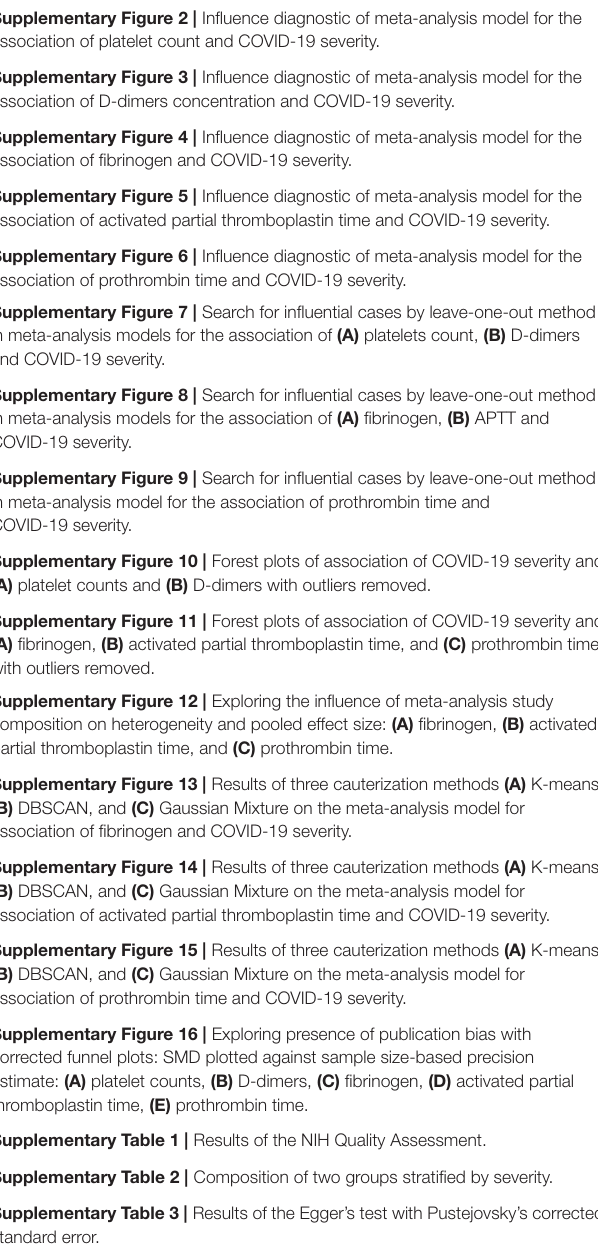
Supplementary Figure 1 | Exploring influential cases in meta-analysis models with Baujat plots: (A) Platelets, (B) D-dimers, (C) Fibrinogen, (D) Activated partial thromboplastin time, (E) Prothrombin time.